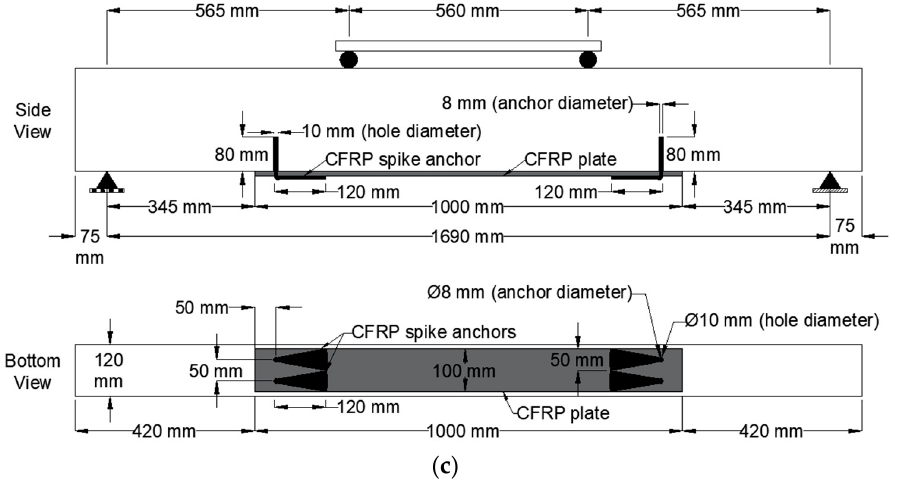
Figure 3. CFRP spike anchor details for specimens: ( a ) S-2A; ( b ) S-4A(d); ( c ) S-4A(s). Table 1. Details of the tested specimens.